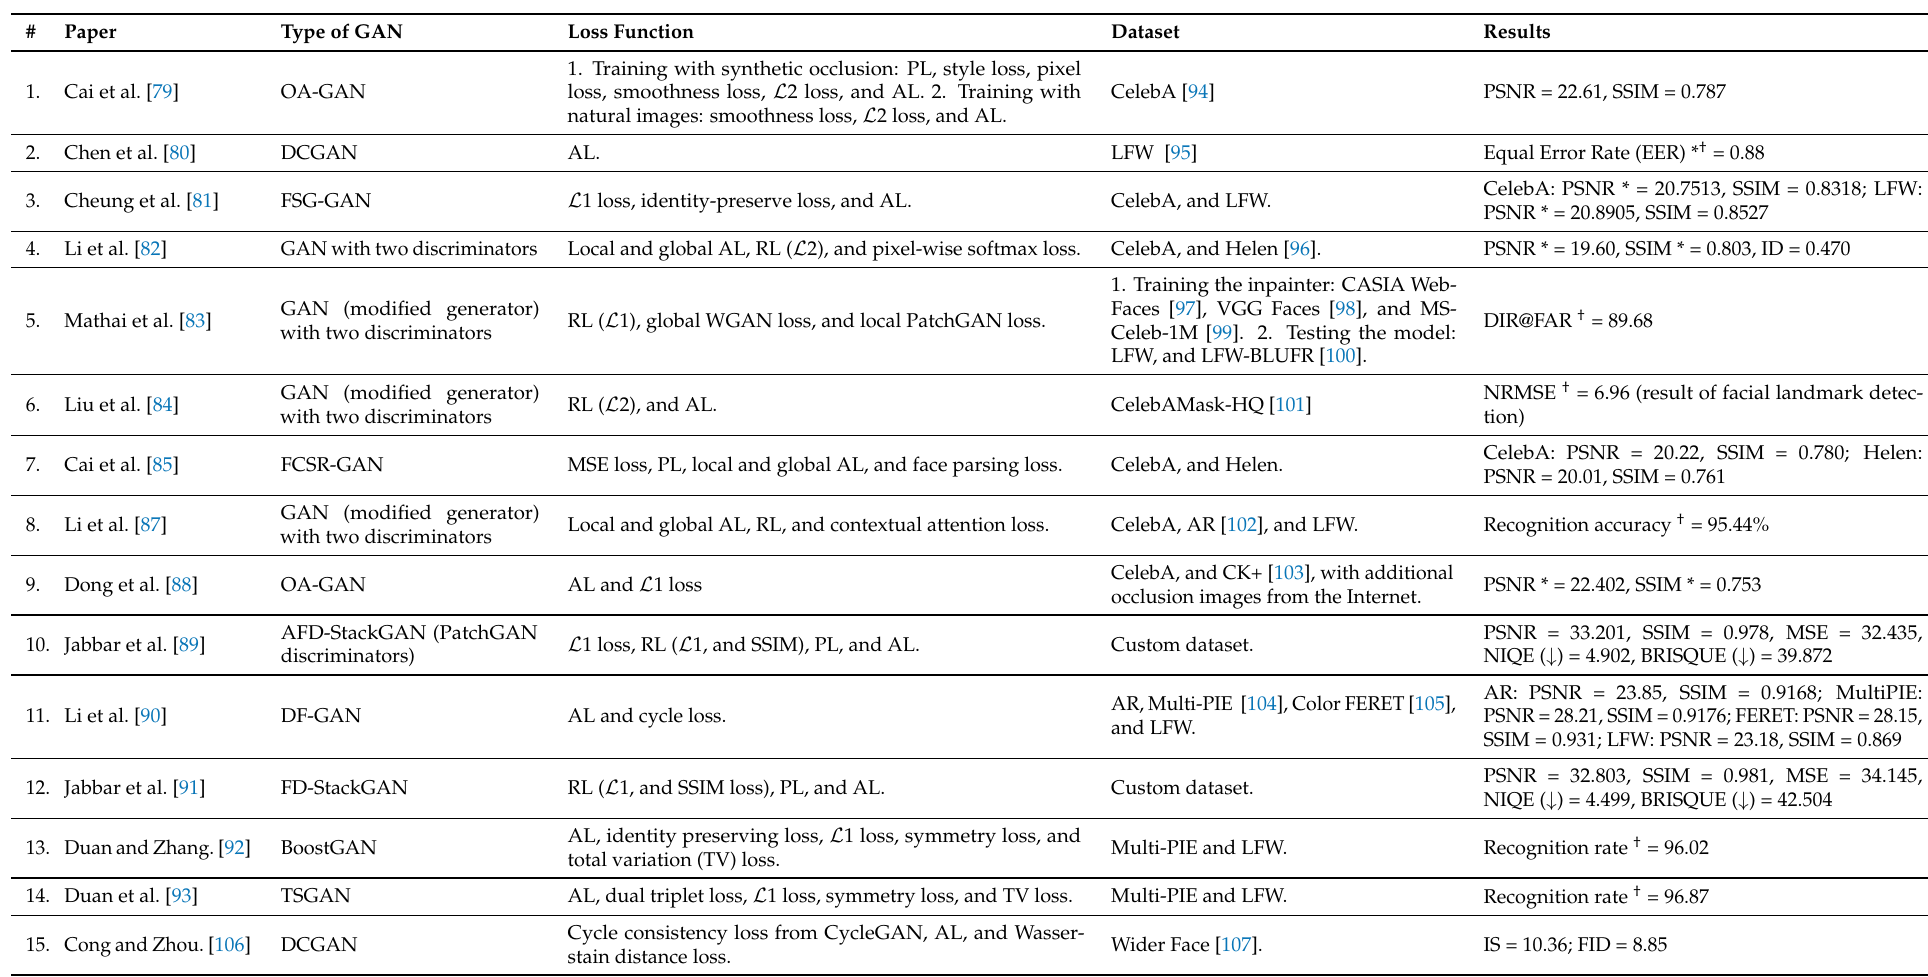
Table 3. Summary of the face completion works, highlighting the types of GAN, loss functions, and the datasets that were used. The results are the reported results of the quality of the generated images (except for the ones marked with †). Results with * are the mean value of the published results. AL: Adversarial loss. PL: Perceptual loss. RL: Reconsturction loss. PSNR: Peak Signal-to-Noise Ratio ↑ . SSIM: Structural Similarity ↑ . ID: Identity Distance ↓ . DIR@FAIR: Detection